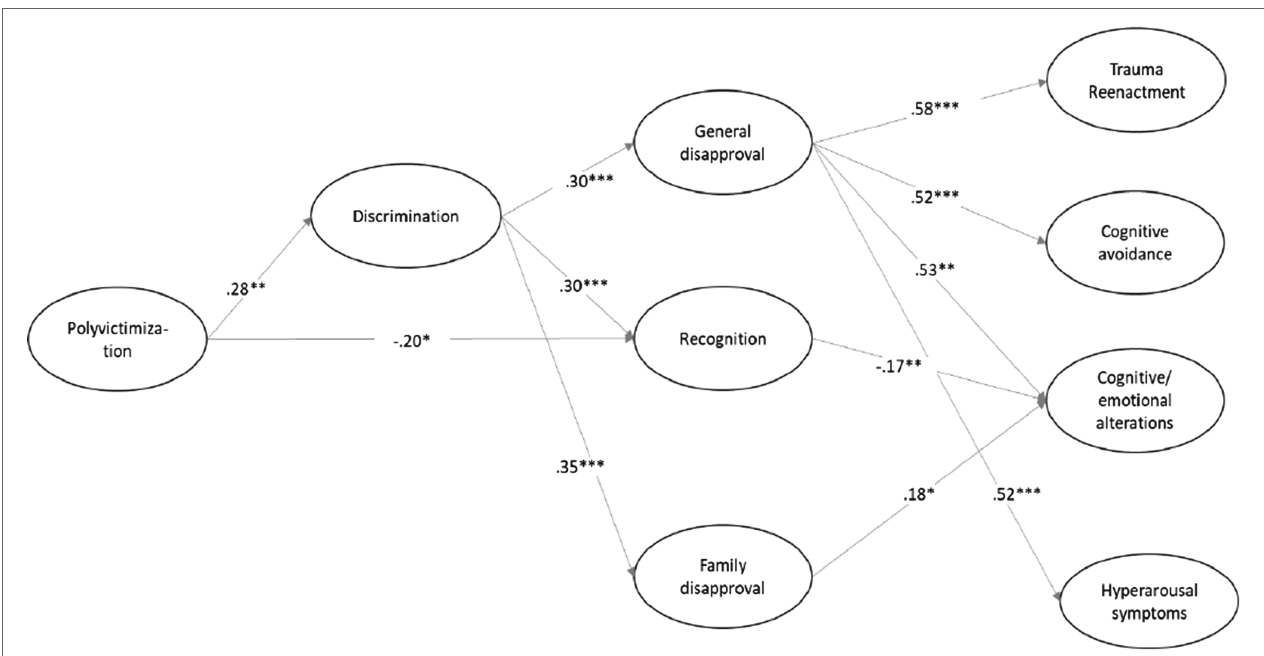
FIGURE 2 | Path analysis and standardized coefficients. Non-significant coefficient were not shown ( p ≤ 0.50) Model fit: χ 2 ( df = 0.36, N = 148) = 746.44, p = 0.0001, CFI = 0.99, TLI = 0.96, RMSEA = 0.07, SMR = 0.014, 95% CI [0.001